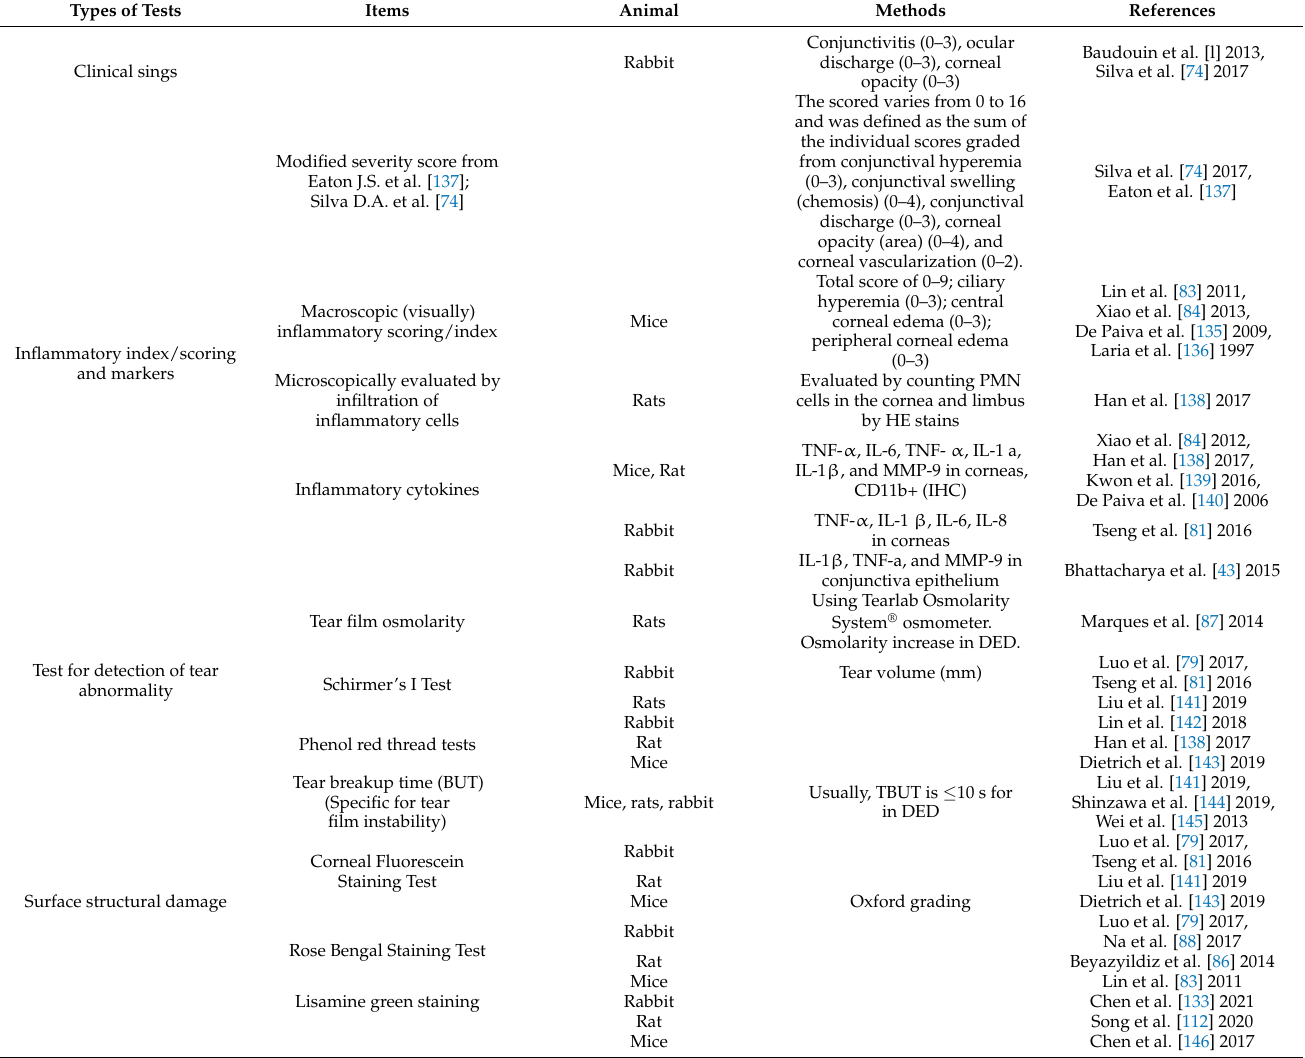
Table 8. Evaluation methods and parameters in experimental